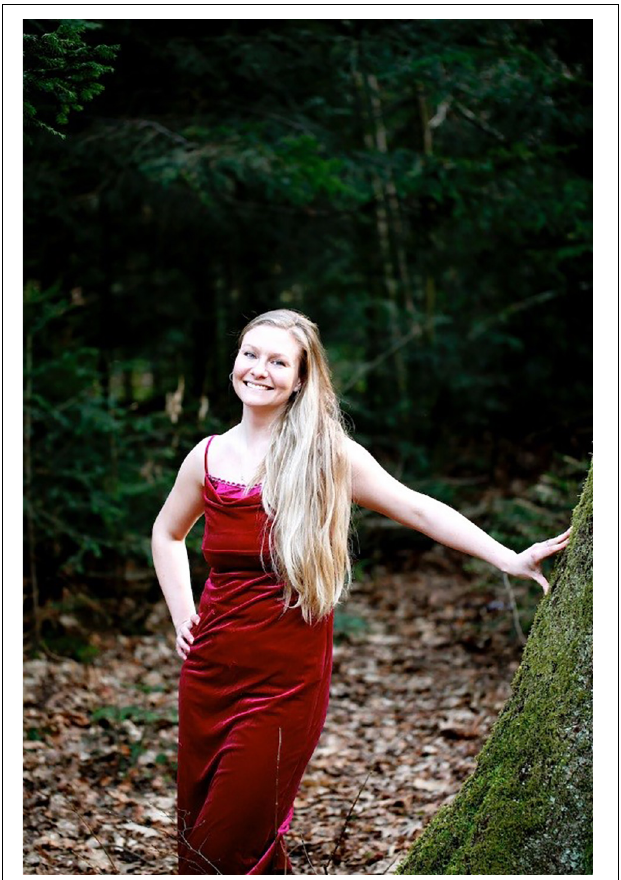
FIGURE 11 | Forests as photo studio (source: Wiebke